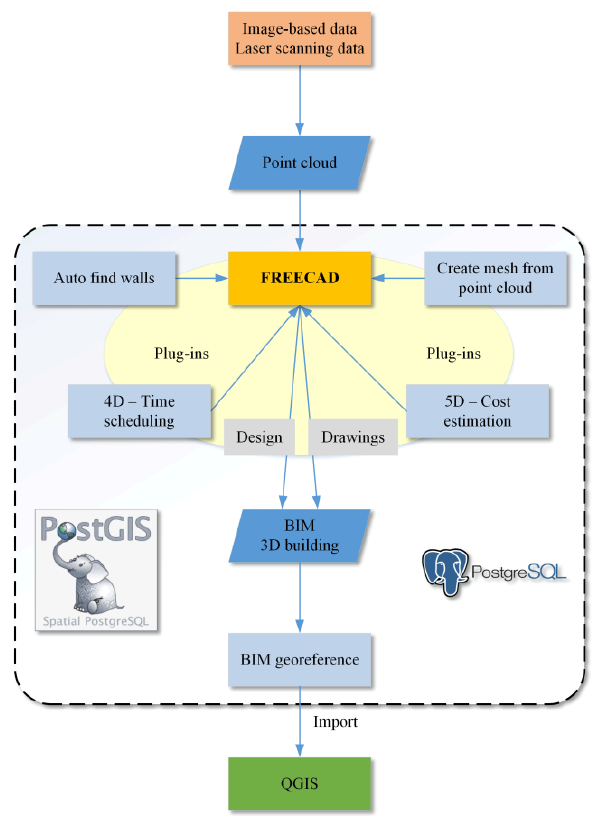
Figure 1: BIM ecosystem around